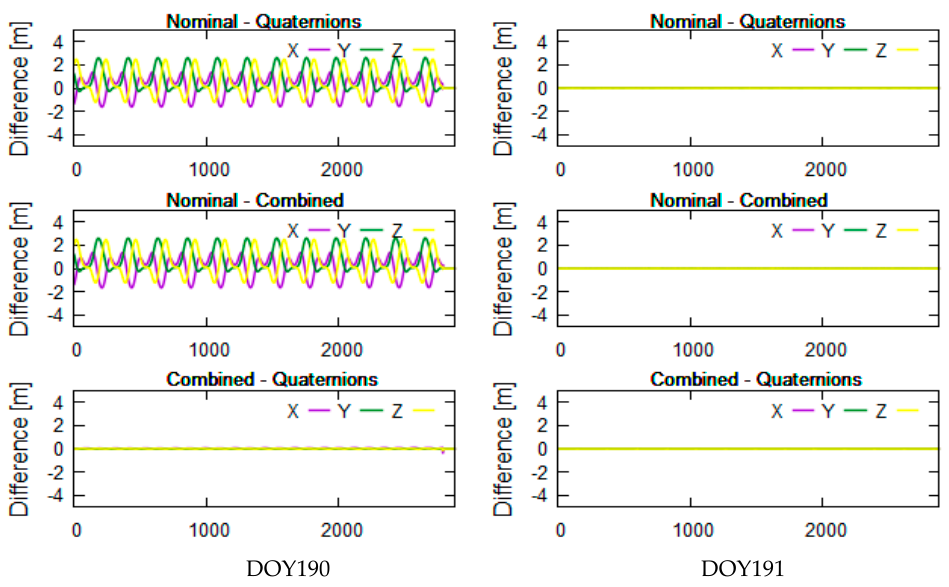
Figure 4. Differences in PCO correction using different attitude modes near + 14.6° .